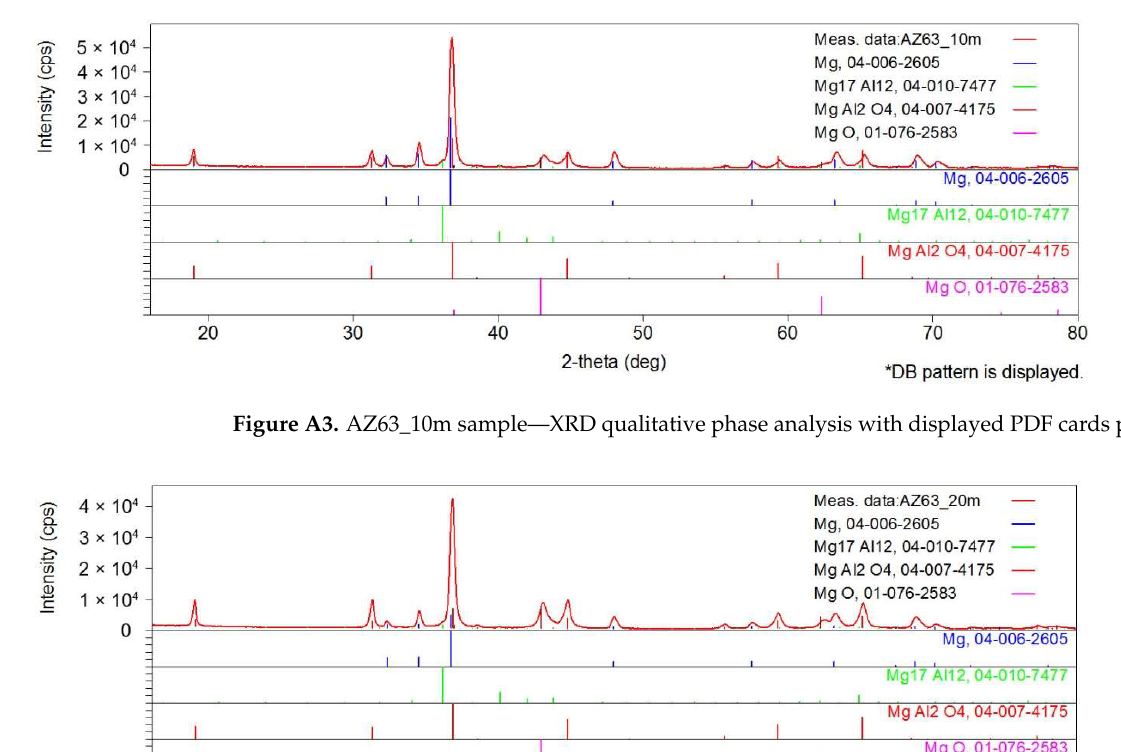
Figure A2. AZ63_5m sample—XRD qualitative phase analysis with displayed PDF cards peak bars.